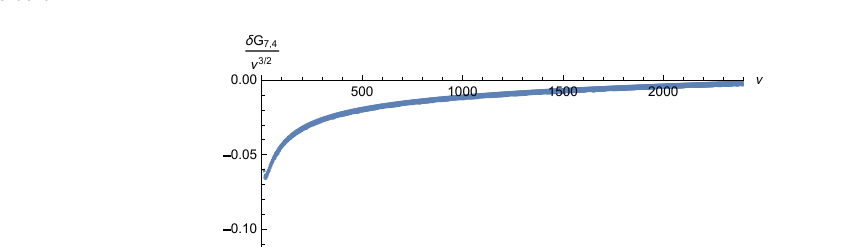
Figure 10 . Subleading tail in G J =2 (cid:25) 2 (cid:23) 5 = 2 versus (cid:23) . We (cid:12)t b 5 (cid:25) 0 : 06365. Again the leading behavior exactly matches the p (cid:0)( 9 ) 4 113400 2 8 prediction.